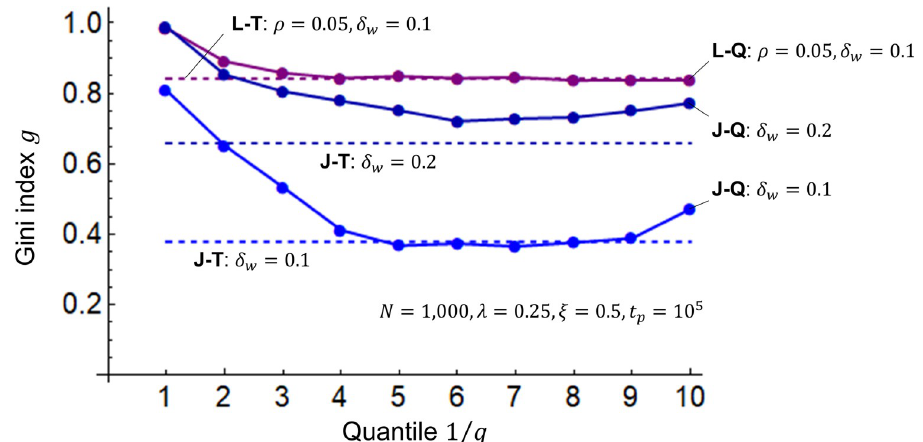
Fig 7. Gini indices for the R-Q, L-Q, and J-Q models. The horizontal axis represents the quantile 1/ q , and the vertical axis represents the Gini coefficient g . The Q model is combined with the R, L, and J models. In the R-Q, L-Q, and J-Q models, the number of agents is N = 1000, the initial values of wealth are m 0.25, and the transfer rate is ξ = 0.5. The L-Q model’s interest rate is ρ = 0.05, and the width of the profit/loss rate δ is δ w = 0.1. The widths of the J-Q model are δ w = 0.1 and 0.2. The period over which the transfer takes place is t p = 10 5 .